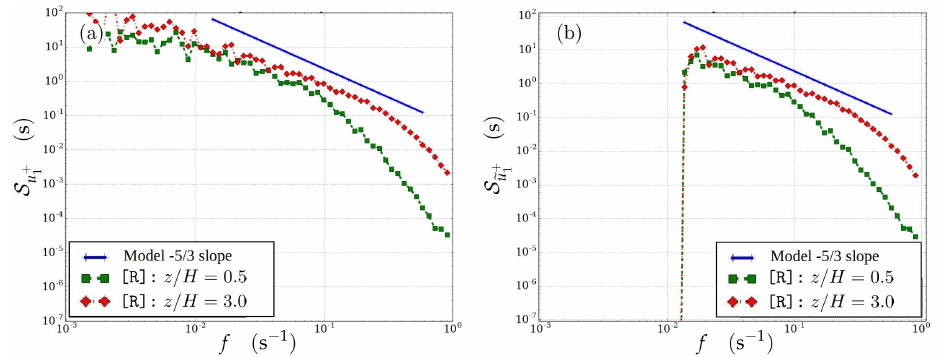
Figure 14. Example spectral energy densities ( S ) of the streamwise-oriented velocity u 1 signal extracted at two heights from simulation [R] and location M6 which cuts through a park with densely packed trees: ( a ) Spectral energy density of the original velocity signal and ( b ) spectral energy density of the filtered (cid:101) u 1 signal (cutoff frequency f c = 0.011s − 1 or scale s c = 2.3 T ).